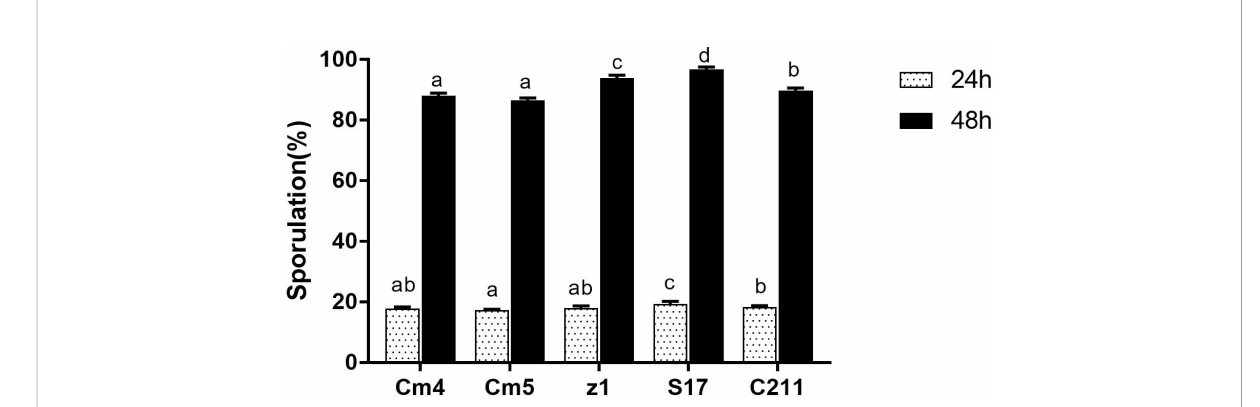
FIGURE 4 Sporulation ef fi ciency of selected strains. The sporulation is expressed as the percentage of spores relative to vegetative cells after 24 h (white bar) and 48 h (black bar). Data are presented as (mean ± SD, n=3) with different superscript letters denoting a signi fi cant differences (p<0.05).